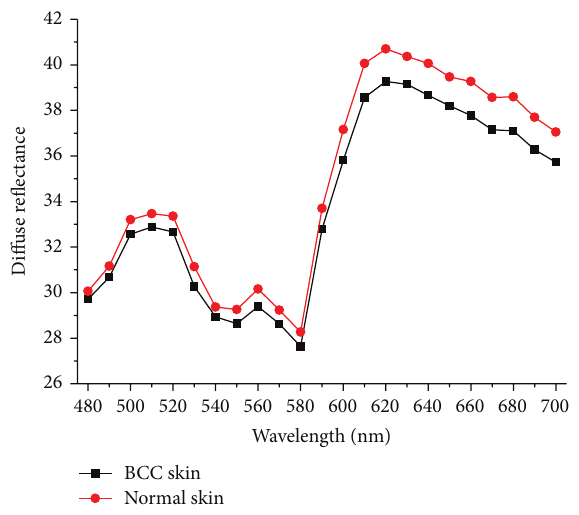
Figure 3: The measured reflectance spectra of BCC skin and normal